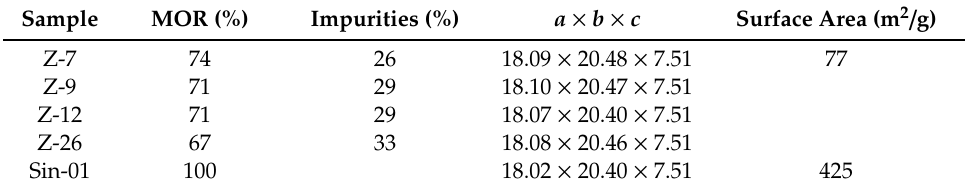
Table 1. Percentage of mineralogical phases obtained for the natural zeolite samples as a result of the estimations calculated from the X-ray di ff raction (XRD) profiles. Unit cell parameters calculated for the natural mordenite phase is also